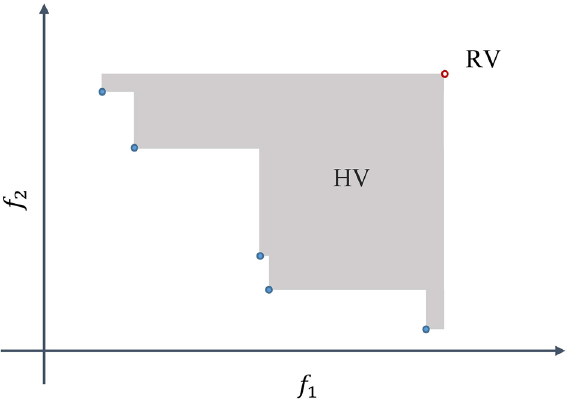
Figure 6. Hypervolume (HV) of one front for two objective functions ( f 1 and f 2 ). Filled circles are solutions in front and empty circle is a reference objective vector (RV).